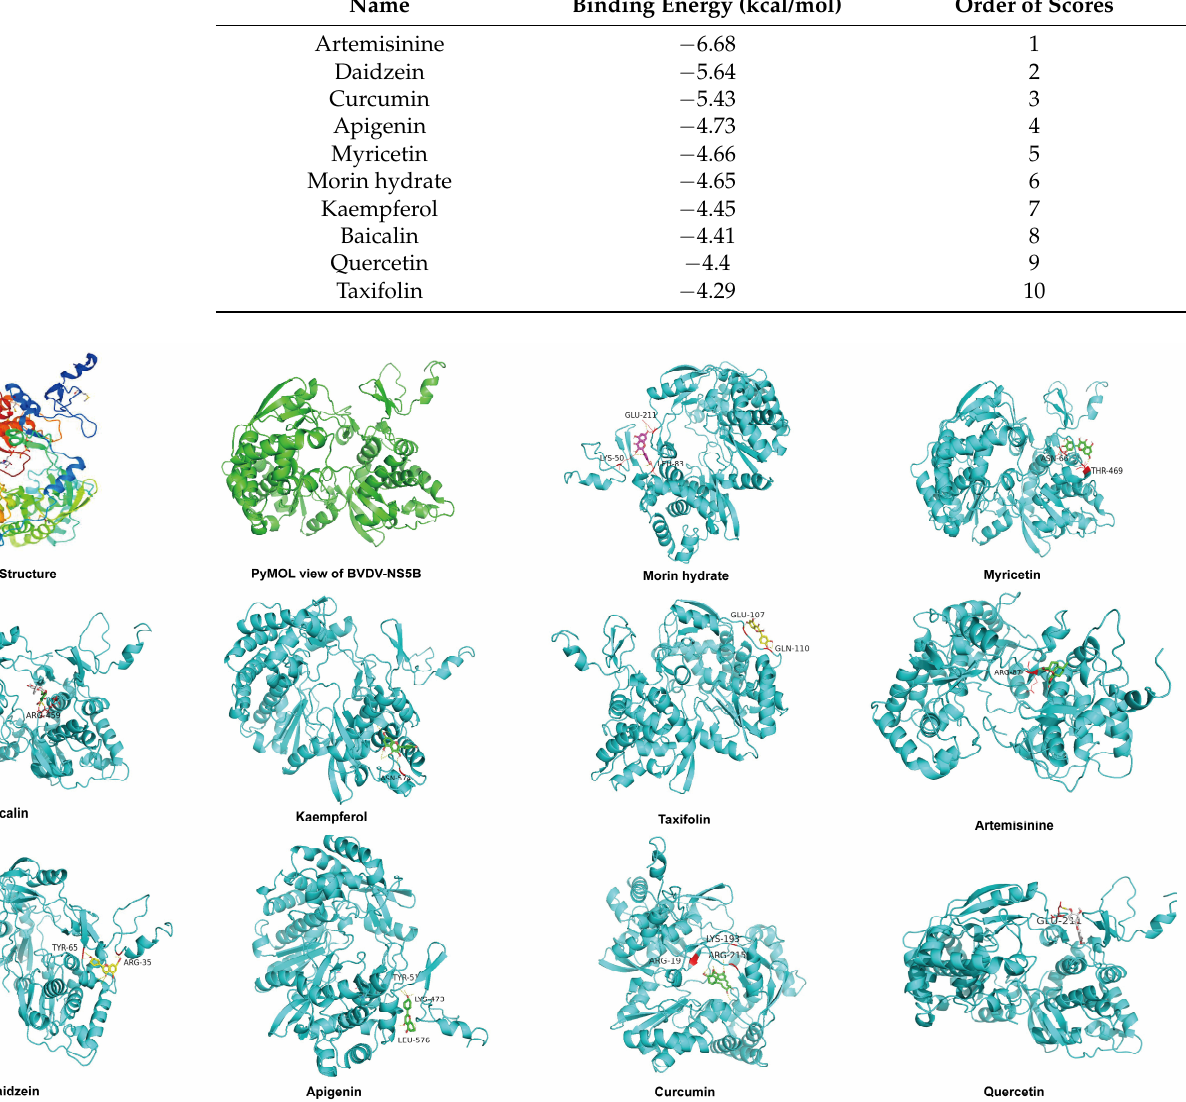
Table 1. Binding energy statistics of Chinese monomers with BVDV-NADL-NS5B.